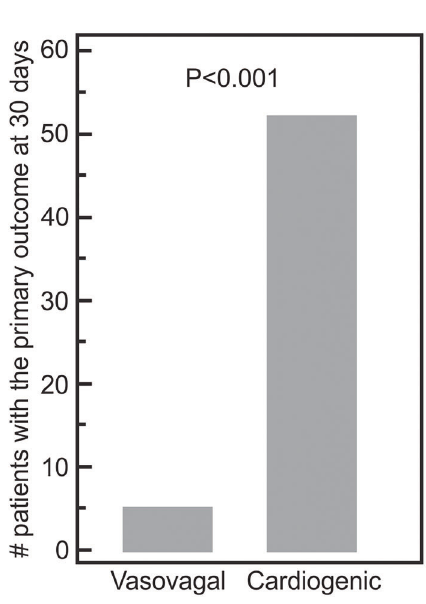
Figure 4. Primary outcome within 30 days in patients with vasovagal and cardiogenic syncope. The outcome was found in 39.4% of vasovagal and 60.6% of cardiogenic (P o 0.001, chi- squared